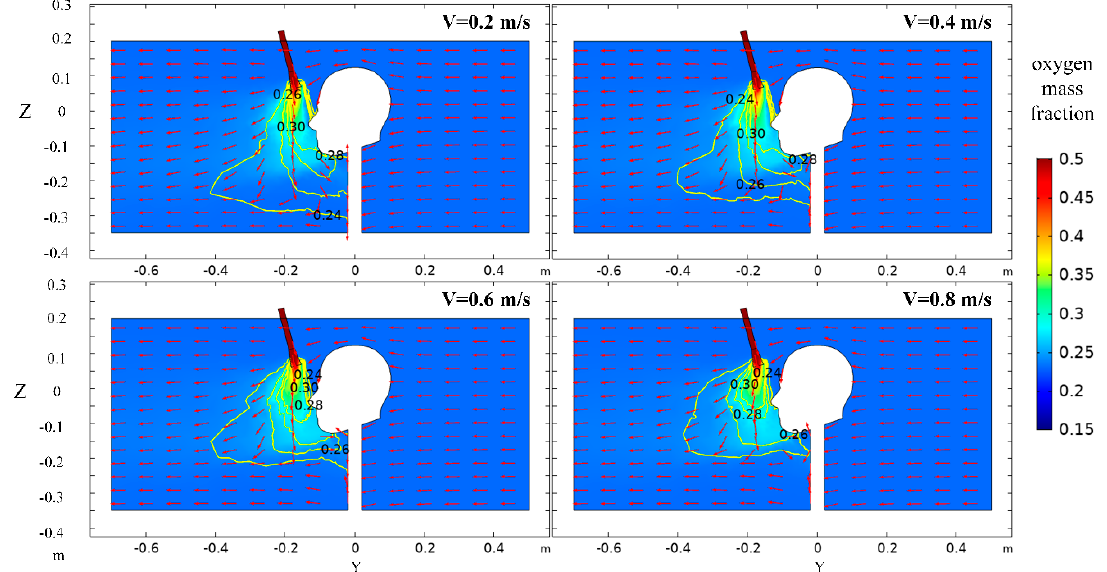
Figure 12. Distribution of oxygen mass fraction in X = 0 m section at different tunnel airflow velocities.